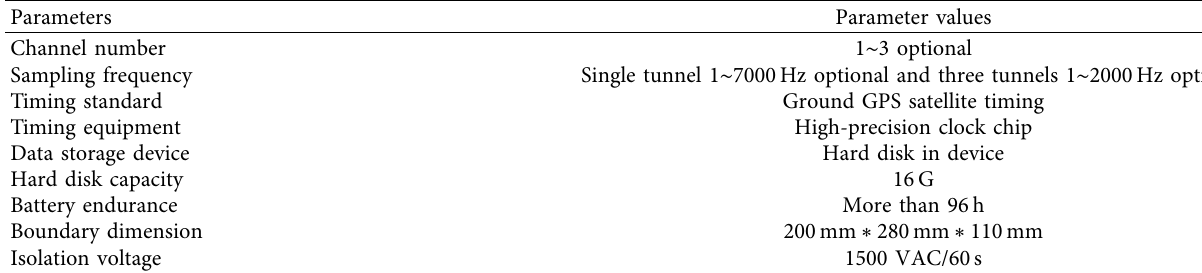
Table 1: Parameters of the detector.